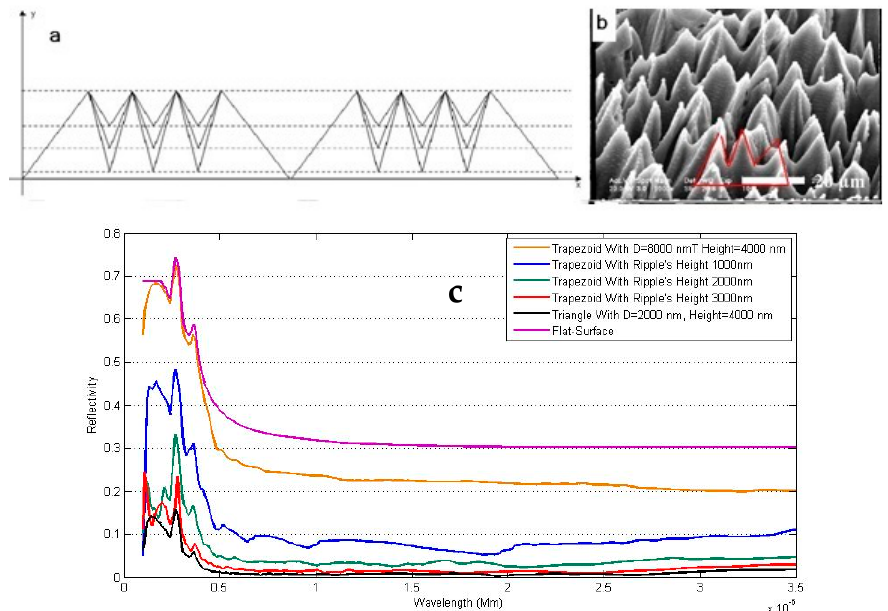
Figure 9. ( a ) Trapezoid-like structures selected for simulation. ( b ) Real trapezoidal structures ob- served in SEM image of the surface texturing [9], ( c ) Simulation results for the microstructures with periodicity and height of 8 and 4 μ m, respectively. Note that the trapezoidal scheme undergoes smaller spectral reflectance for wavelengths longer than ~500 nm with respect to those of the trian- gular model.